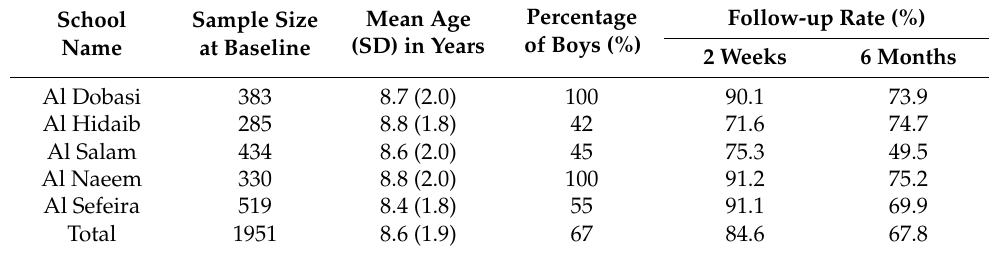
Table 1. General characteristics of the study population at baseline and follow-up